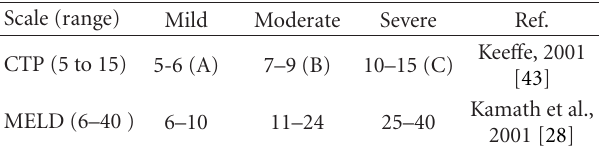
Table 1: Assessing liver disease severity in decompensated HBV